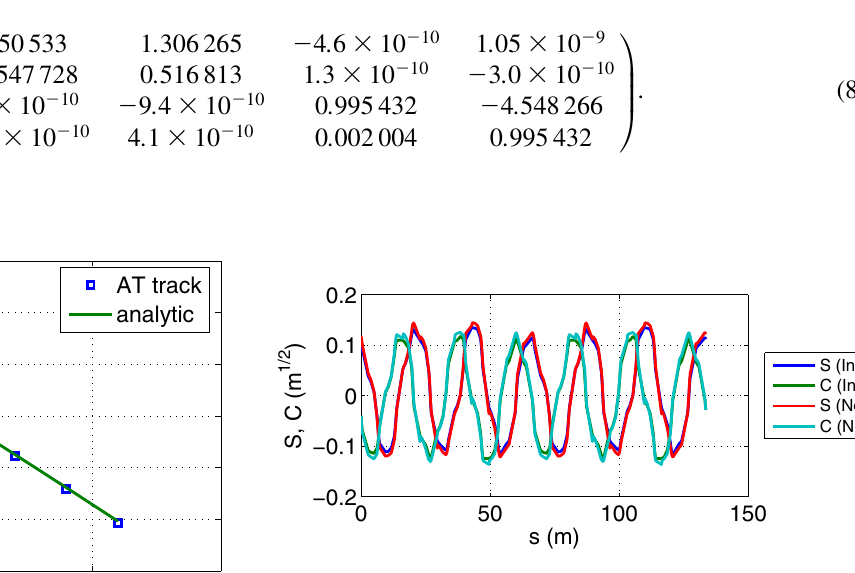
FIG. 2. (Color) Function S and C as defined in Eq. (68) for the SPEAR Booster at 3 GeV. The curves labeled ‘‘Int’’ are from numerical integration with the trapezoidal rule by cutting each dipole into 100 slices. The ‘‘Non’’ curves are obtained by calculating the coordinate shifts at the exit of each dipole, transporting to the observation point and summing up contribu- tions of all